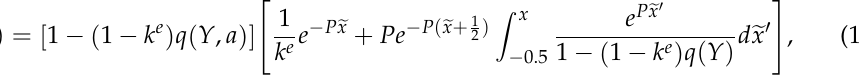
Figure 3. Variation of partition coefficient as a function of P . 𝑘(𝑃) = 𝑘 𝑒 + 𝛾𝑃 1 + 𝛾𝑃 , (124) where,